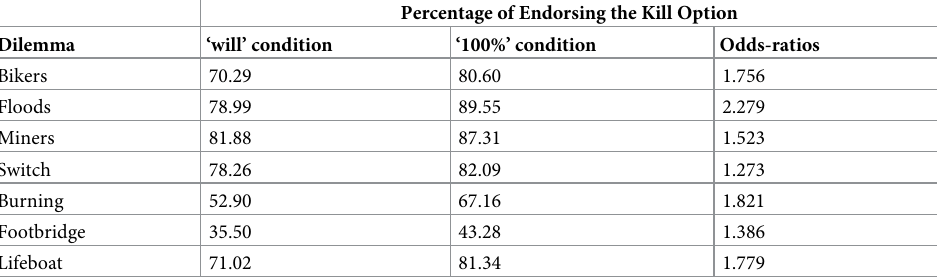
Table 4. Choice behavior when outcome probability information is presented linguistically and